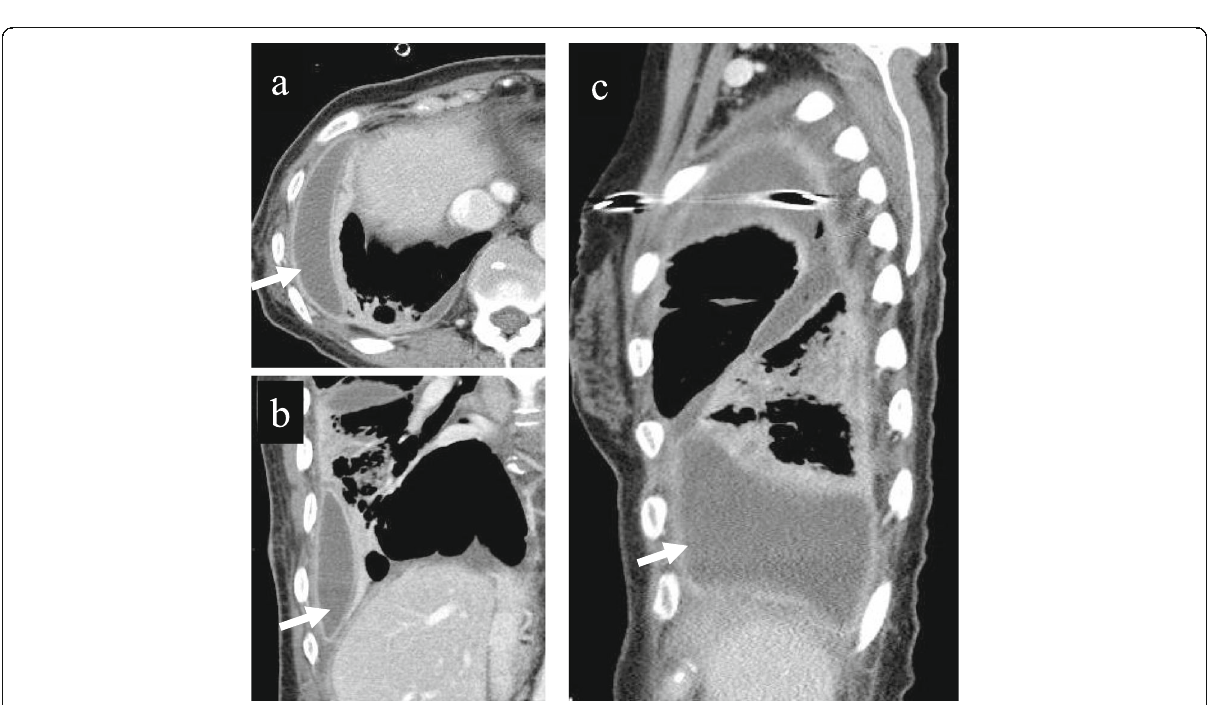
Fig. 4 Cavity III: This cavity was located from the outside of the right lower lobe to the diaphragm. Axial view ( a ), coronal view ( b ), and sagittal view ( c ) of chest CT findings at admission. For this cavity, usual debridement under thoracoscope was possible without using